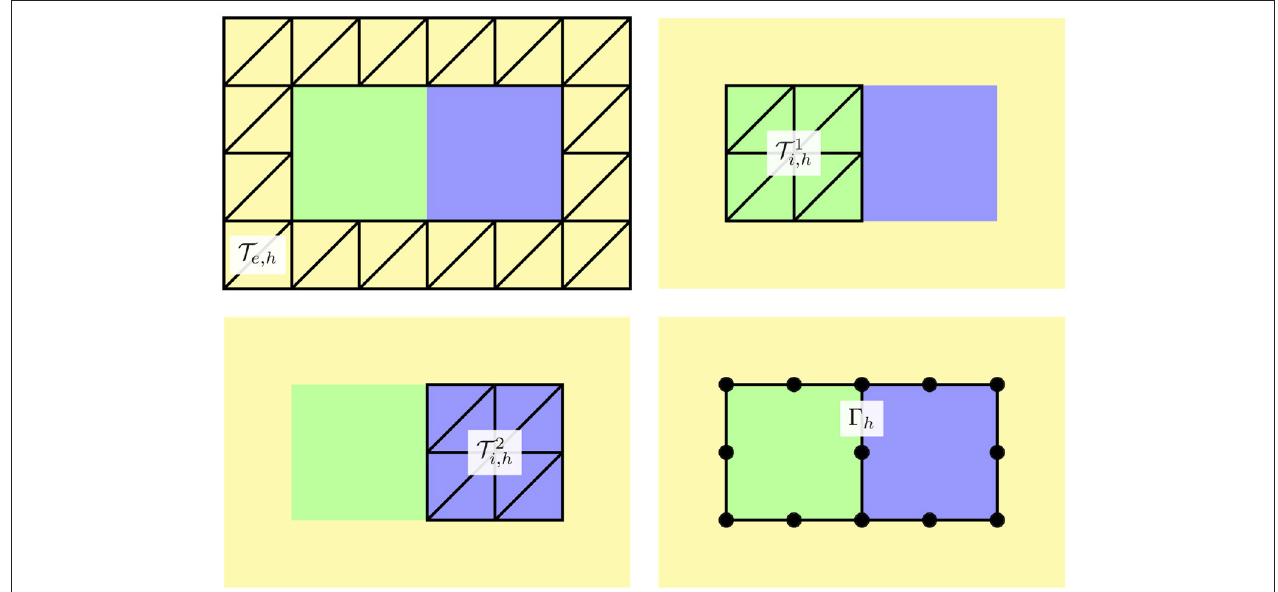
FIGURE 3 | Schematic representation of finite element meshes considered with the mortar element method: (upper left) the tesselation T e , h of the extracellular domain, (upper right and bottom left) the tessellations T 1 i , h and T 2 i , h of the intracellular domains, and (bottom right) the membrane discretization Ŵ h . In our implementation, T e , h and T k i , h have identical facets on Ŵ and the facets define the finite element cells of Ŵ h , see the location of the vertices of the 1D mesh depicted by black